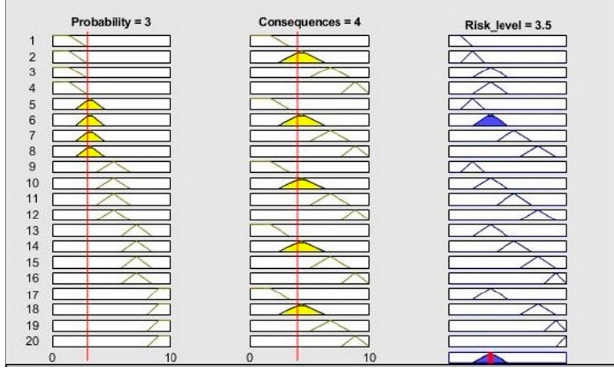
Figure 7. Rules of probabilities and consequences for risk level calculation.